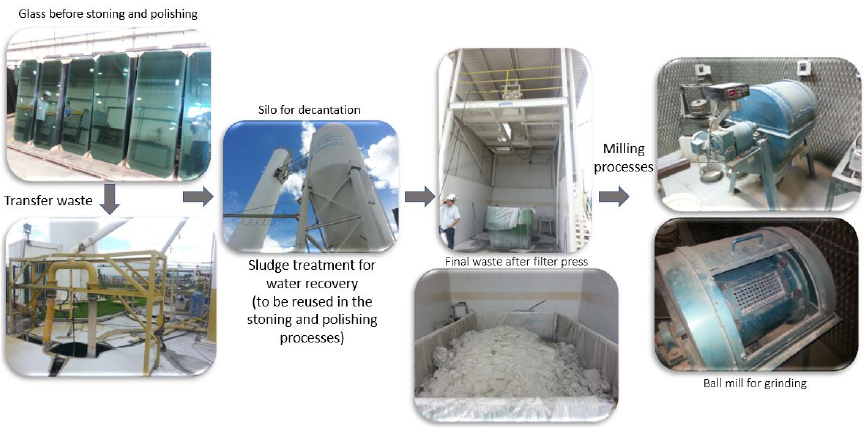
Figure 7. Process from polishing and lapping the glass to grounding for incorporation into concrete.